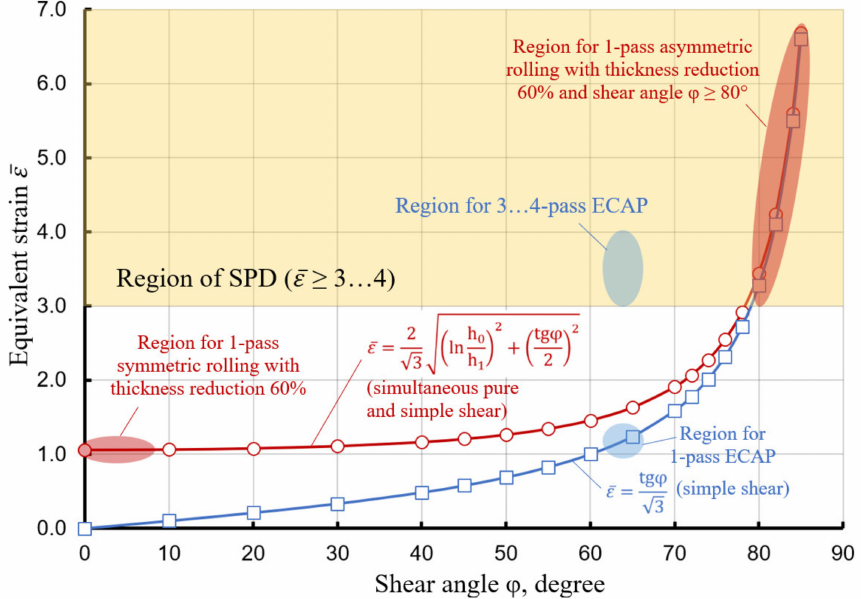
Figure 26. Influence of the shear angle ϕ on the equivalent strain ε during symmetric rolling, asymmetric rolling and ECAP.